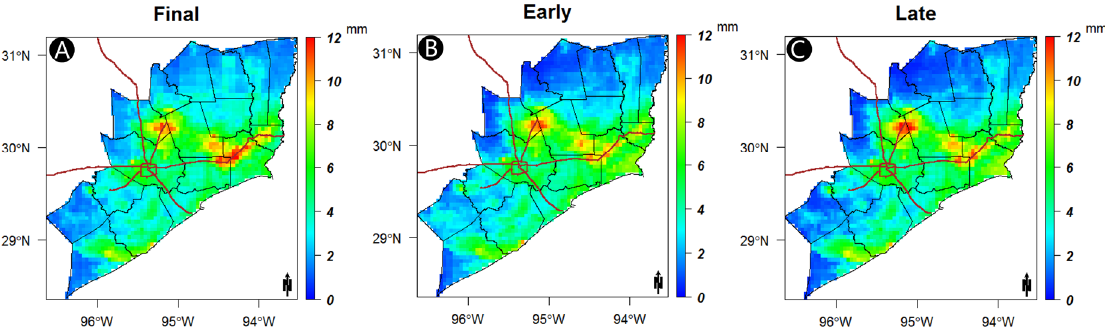
Figure 7. Spatial distribution of RSME for the IMERG ( A ) Early-, ( B ) Late-, and ( C ) Final-run hourly products during Tropical Storm Imelda.